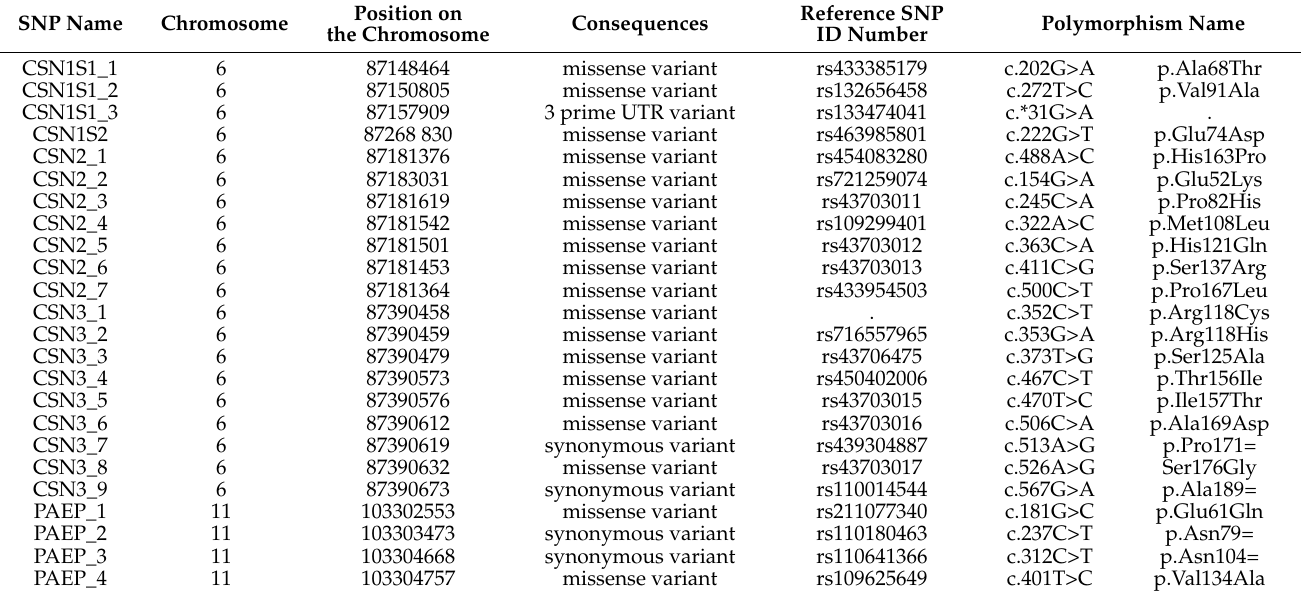
Table 1. Single Nucleotide Polymorphism (SNP) information (UMD3.1 reference